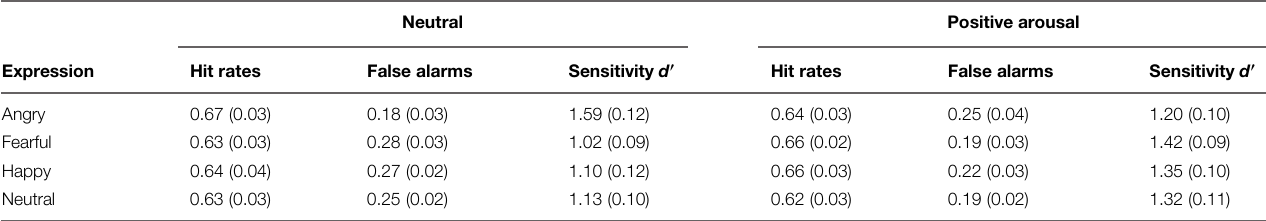
TABLE 2 | Mean d (cid:2) scores for the mood conditions of Experiment